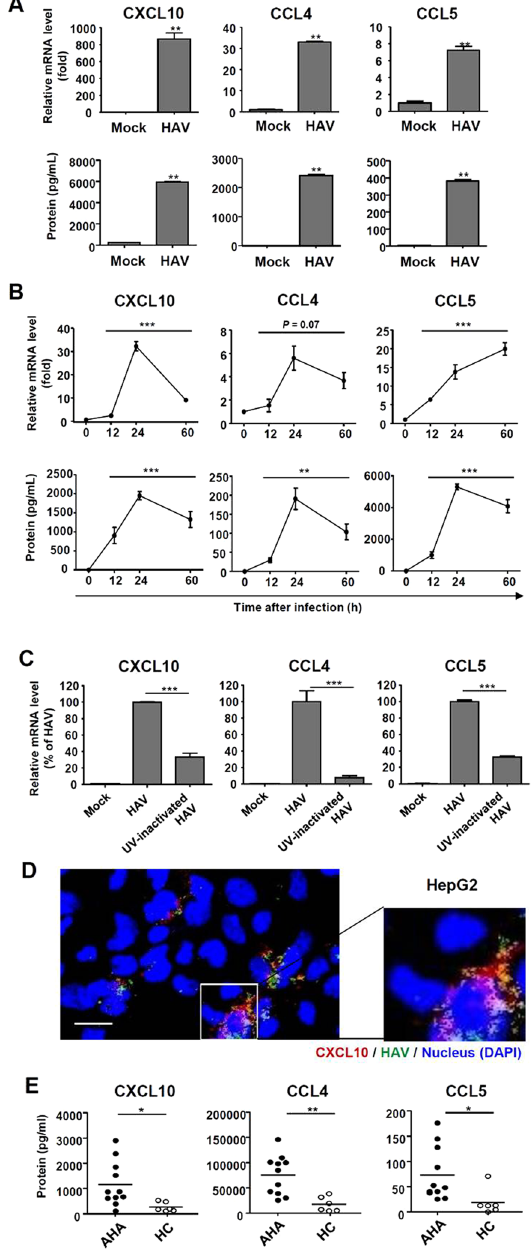
Figure 2. Production of CXCL10, CCL4, and CCL5 in HAV-infected cells. ( A ) PHHs were infected with HAV at 500 GE/cell. After 24 hours, cell pellets and culture supernatants were harvested. Real-time qPCR (upper row) and ELISA (lower row) were performed to examine the production of CXCL10, CCL4, and CCL5. Bar graphs represent the means ± s.e.m. (n = 3). Unpaired t-tests were performed. ** P < 0.01 compared to mock infection. ( B ) HepG2 cells were infected with HAV at 200 GE/cell. Cell pellets and culture supernatants were harvested after HAV infection. Real-time qPCR (upper row) and ELISA (lower row) were performed to examine the production of CXCL10, CCL4, and CCL5. Means ± s.e.m. are shown (n = 3). Repeated measures ANOVA tests were performed. ** P < 0.01, *** P < 0.001. ( C ) HepG2 cells were infected with mock, HAV, or UV-inactivated HAV at 200 GE/cells. After 30 hours, cell pellets were harvested. Real-time qPCR was performed to examine the induction of CXCL10, CCL4, and CCL5. Bar graphs represent the means ± s.e.m. (n = 3). Unpaired t-tests were performed. *** P < 0.001 compared to HAV infection. ( D ) HepG2 cells were infected with HM-175/18 f HAV at 50 GE/cell. After 48 hours, immunofluorescence staining was performed to examine the expression of CXCL10 and HAV antigen. Nucleus was stained with DAPI. Data from three independent experiments are presented. Scale bar represents 10 μ m. ( E ) Sera from acute hepatitis A (AHA) patients (n = 11) and healthy controls (HC) (n = 6) were analyzed for CXCL10, CCL4, and CCL5 protein. Bar graphs represent the means ± s.d. Unpaired t-tests were performed. * P < 0.05, ** P < 0.01 compared to